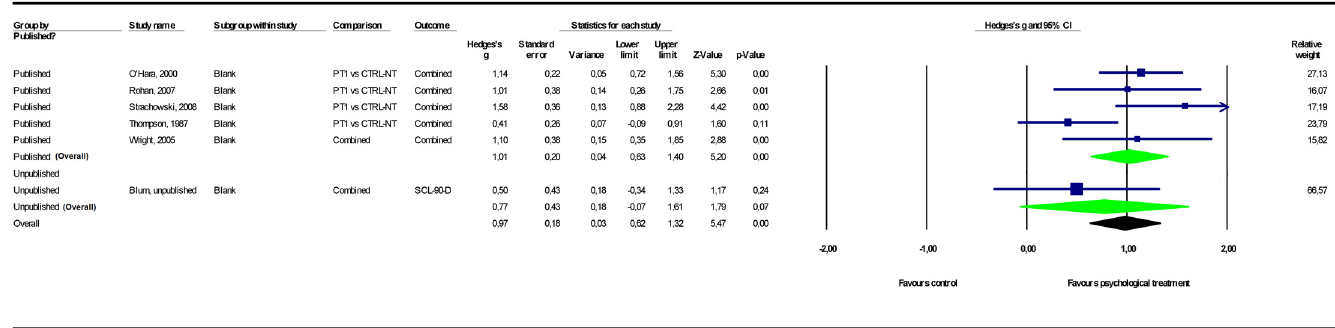
Fig 3. Psychological treatment versus no-treatment control conditions. Note: Not all results of the unpublished studies are presented at study level, because we did not have permission of the investigators to do so. CTRL-NT = no-treatment control condition; PT = psychological treatment; SCL- 90-D = Symptom Checklist — 90 item, depression